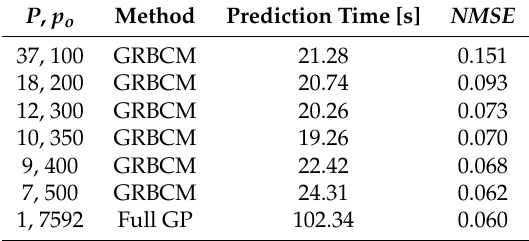
Table 3. Performance evaluation for 2D field estimation with dataset with N = 7592 measurements, R = 214,500 2D test points (390 550), grid resolution 0.1 m, hyperparameter l = 0.25 m, sampling k = 3 l . × We variate P and p 0 = N / P (number of local experts and their size, respectively). P , p o